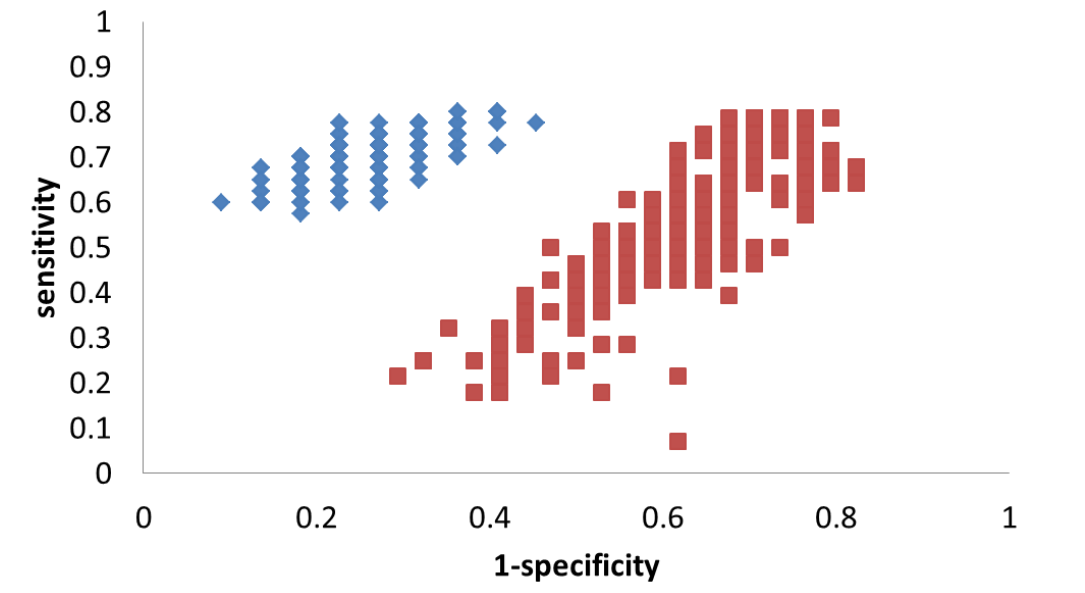
Figure 4. Results of the MCCV results (200 iterations) shown in ROC space for PLS-DA models based on the 3 metabolites used to discriminate HCC from HCV. Each blue diamond represents an iteration of the true model; each red square represents an iteration of the permutation